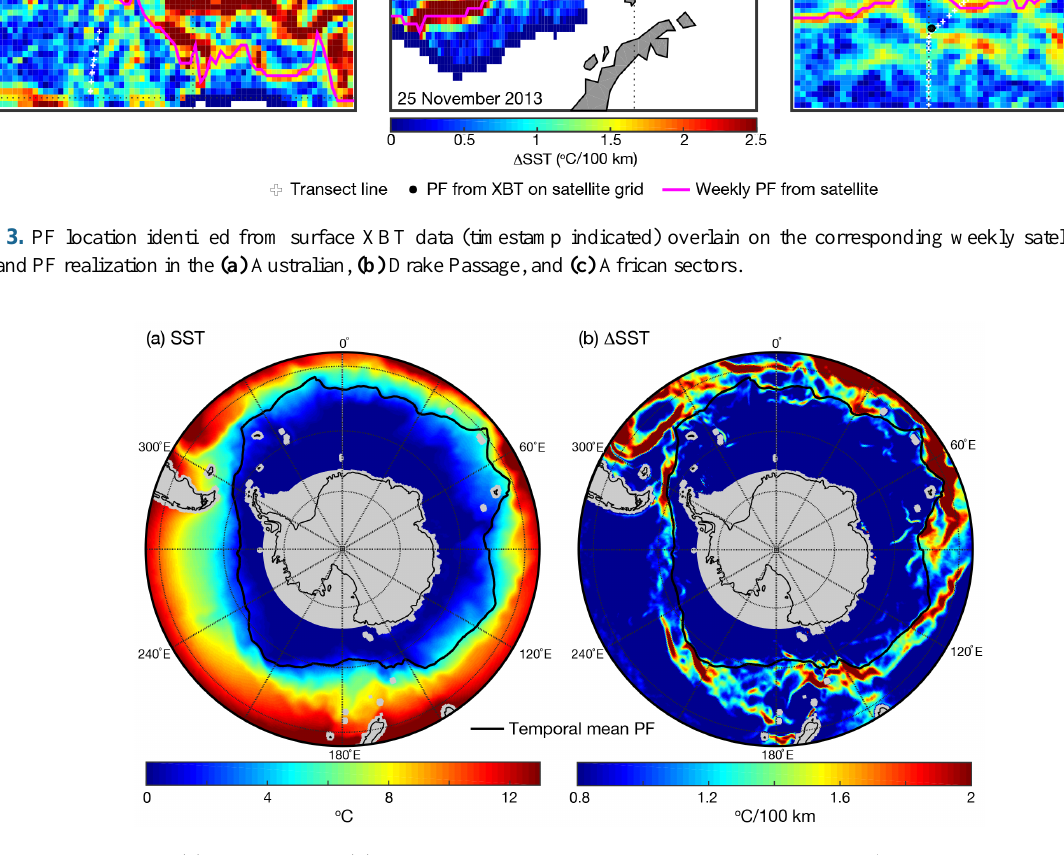
Figure 4. Southern Ocean (a) mean SST and (b) absolute SST gradient with climatological PF overlain (June 2002–February